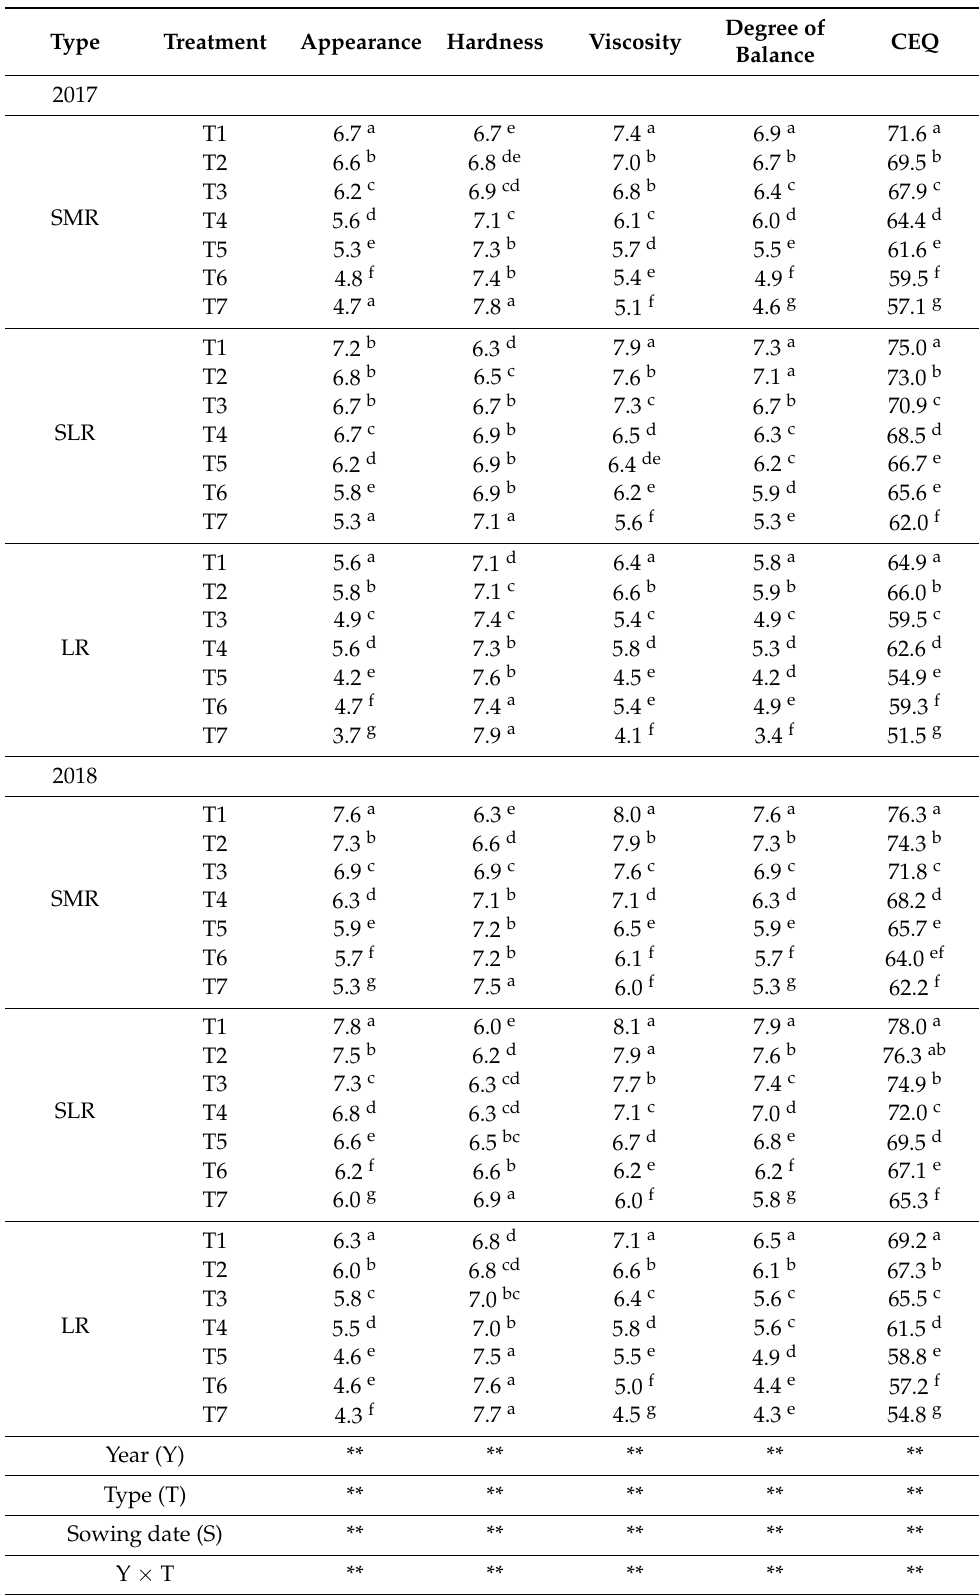
Table 2. Influence of T and R on the eating quality of different types of rice 1 .